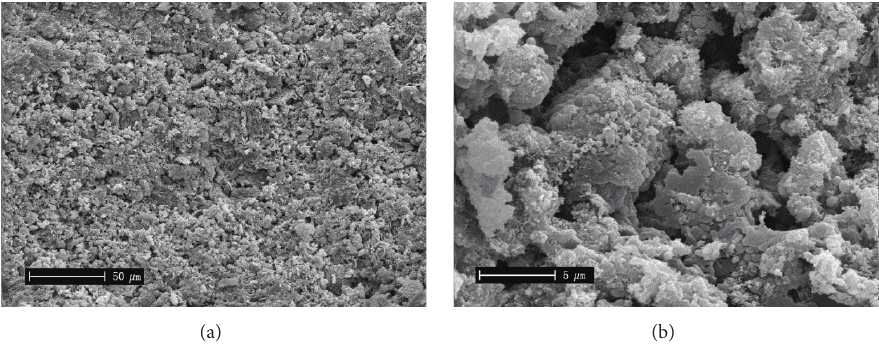
Figure 10: SEM images of microstructure of PC exposed at 300 ∘ C for 5.5 h at (a) 1000x and (b) 10000x magnification.